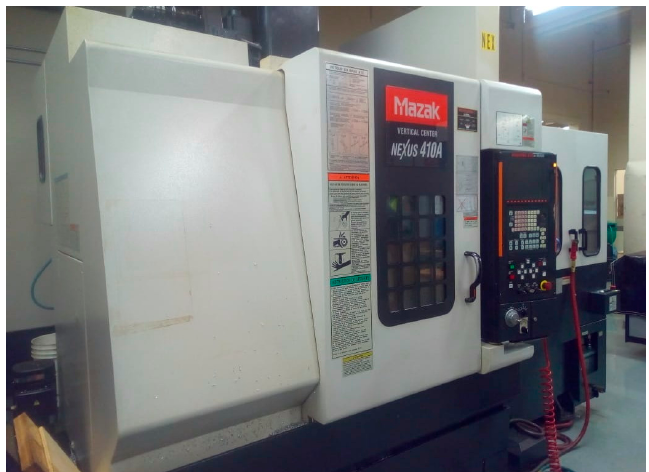
Figure 4. MAZAK NEXUS 410A CNC vertical milling machine.